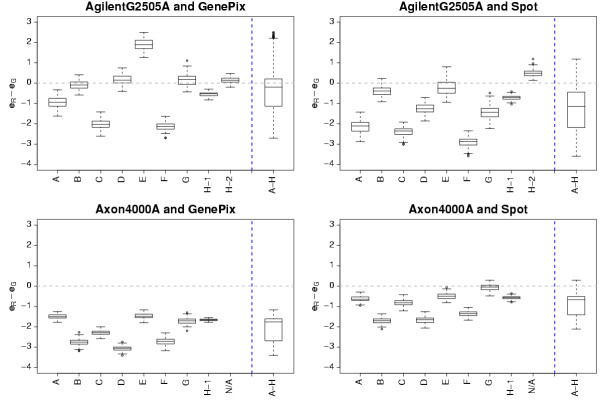
Comparison of bias estimates between channels. Differences in the common biases ec between the red and the green channel for each separate array and for all arrays together. At the top is data from the Agilent scanner and at the bottom from the Axon scanner. Data in the left column by GenePix and Data in the right column was quantified by Spot. For data from the Axon scanner the common bias is greater in the green channel than the red channel, especially for GenePix quantified signals. For the Agilent scanner this trend is less clear although the Spot quantified signals clearly seem to have a higher bias in the green than the red channel.